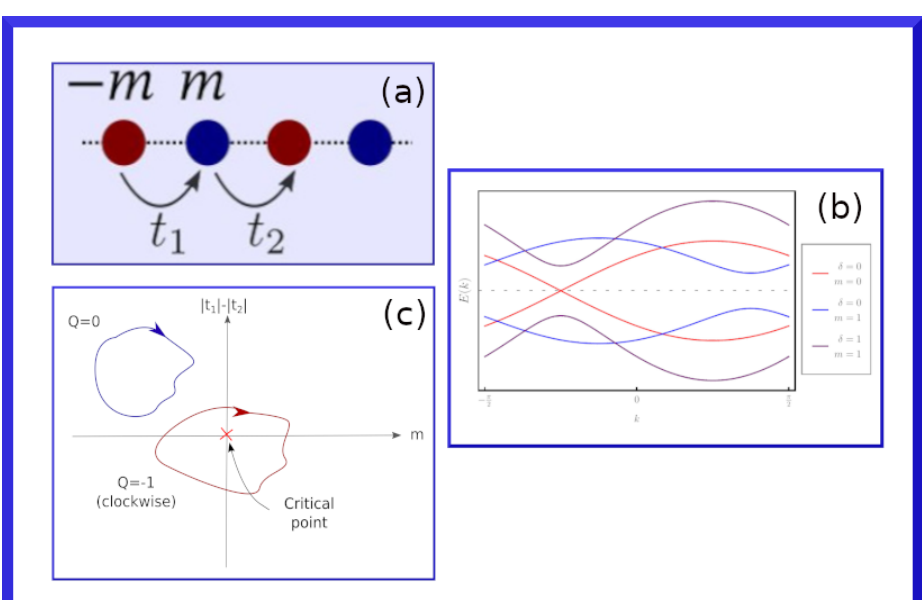
Figure 1: Panel (a): the Rice-Mele lattice. Panel (b): the energy bands for Rice-Mele Hamiltonian for different values of m , δ = | t critical point is found at m = 0 and δ = 0. Panel (c): the pumped charge Q after the completion of a full adiabatic cycle is the winding number around the critical point in the parameter space of the Rice-Mele